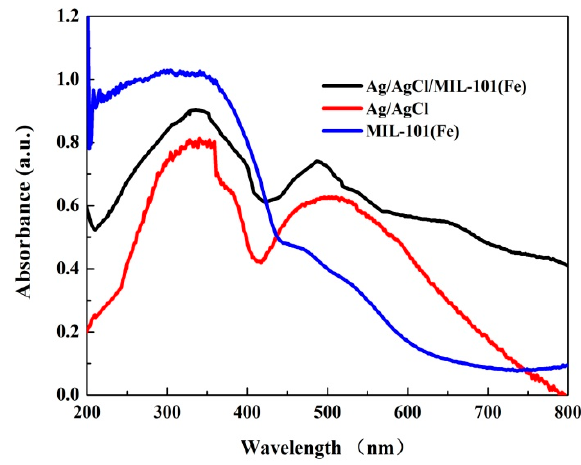
Figure 7. UV ‐ vis diffuse reflectance spectra of the MIL ‐ 101(Fe) and Ag/AgCl/MIL ‐